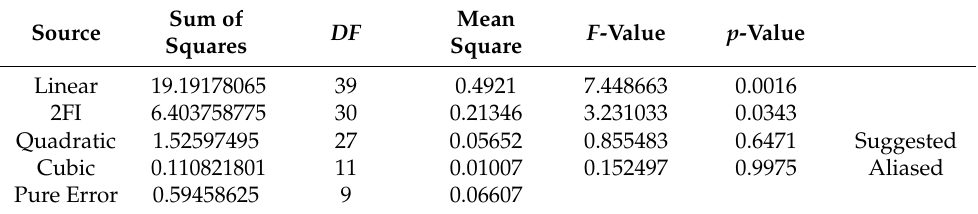
Table 5. “Lack of fit” test.